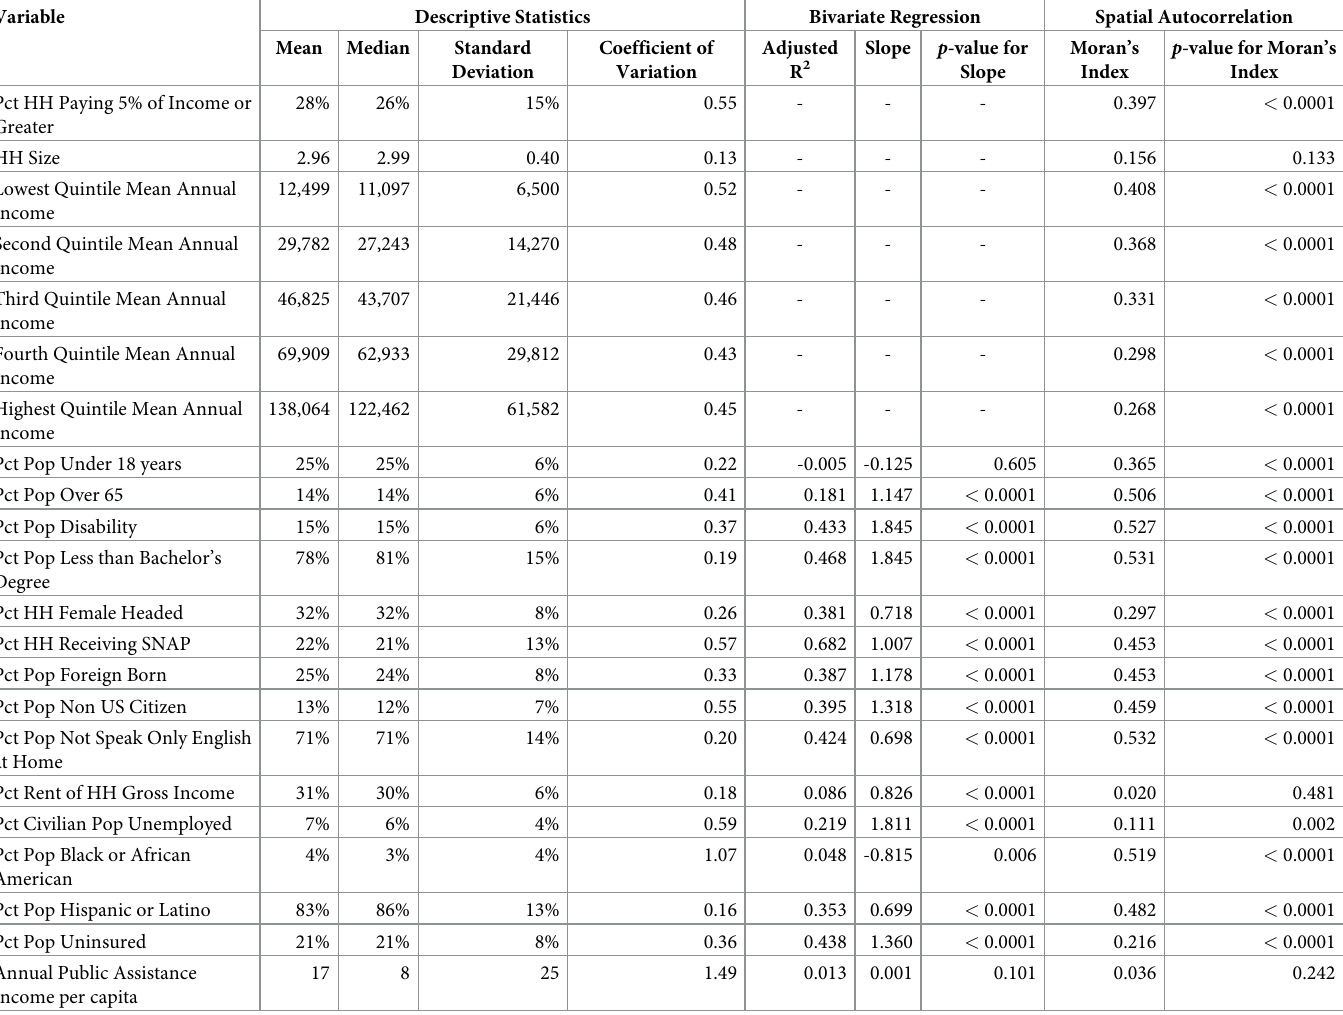
Table 4. Descriptive statistics and results from bivariate regressions and spatial autocorrelation